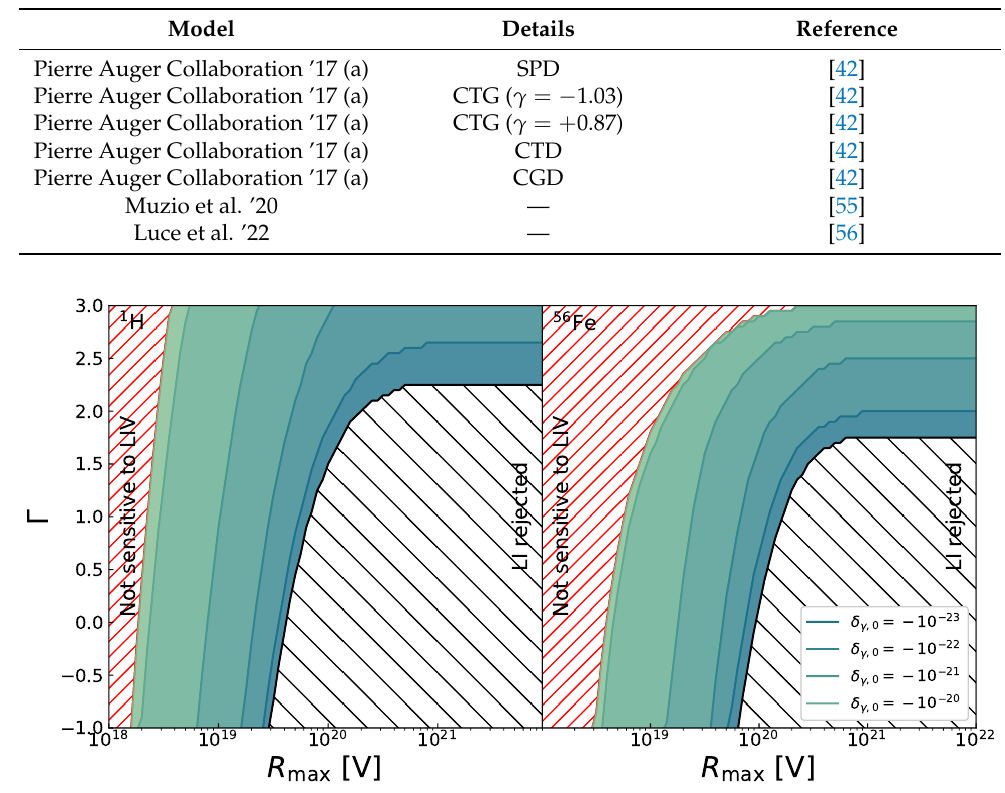
Figure 3. Limits on the subluminal LIV coefficient for the phase space of generic UHECR models. The left and right panels are, respectively, for a pure composition of proton and iron. The shaded red area shows the region of the phase space for which the models are not sensitive to LIV. The shaded black area shows the region already ruled out even in a LI scenario. The different colors show the regions in which the imposed limits would be of a given logarithmic